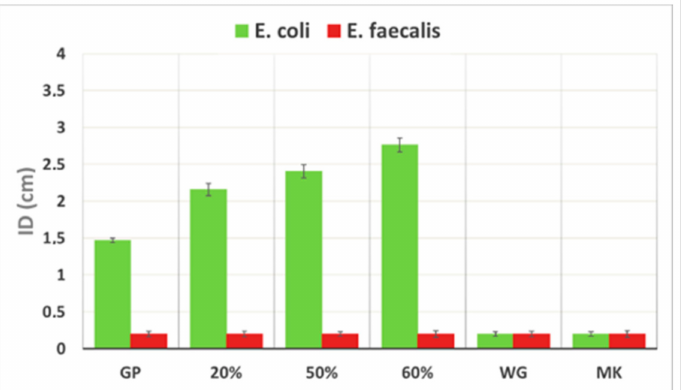
Figure 11. Comparison of inhibition halo of E. coli and E. faecalis for MK, WG, GP, and GP/WG samples. The percentages indicate the waste glass content in the geopolymer formulations. Please consider that the dimension of the IDs is in relation to Petri Plate diameter (PPD) (6 cm), thus the maximum value for ID is 6